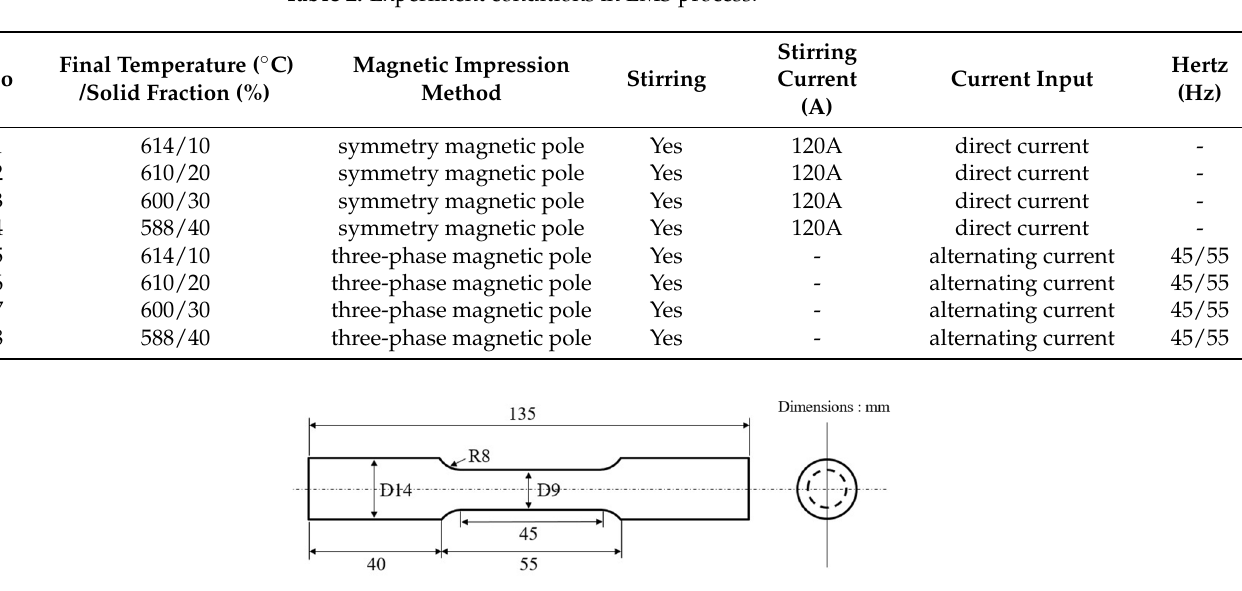
Figure 3. Process of rheocasting using EMS: ( a ) Stirring, ( b ) Injection. Table 2. Experiment conditions in EMS process.